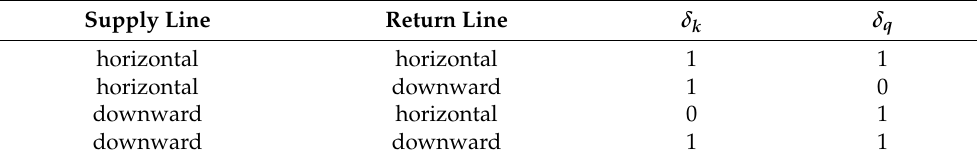
Table 1. Propagation parameters and pipe direction with respect to the inlet and outlet of the collector